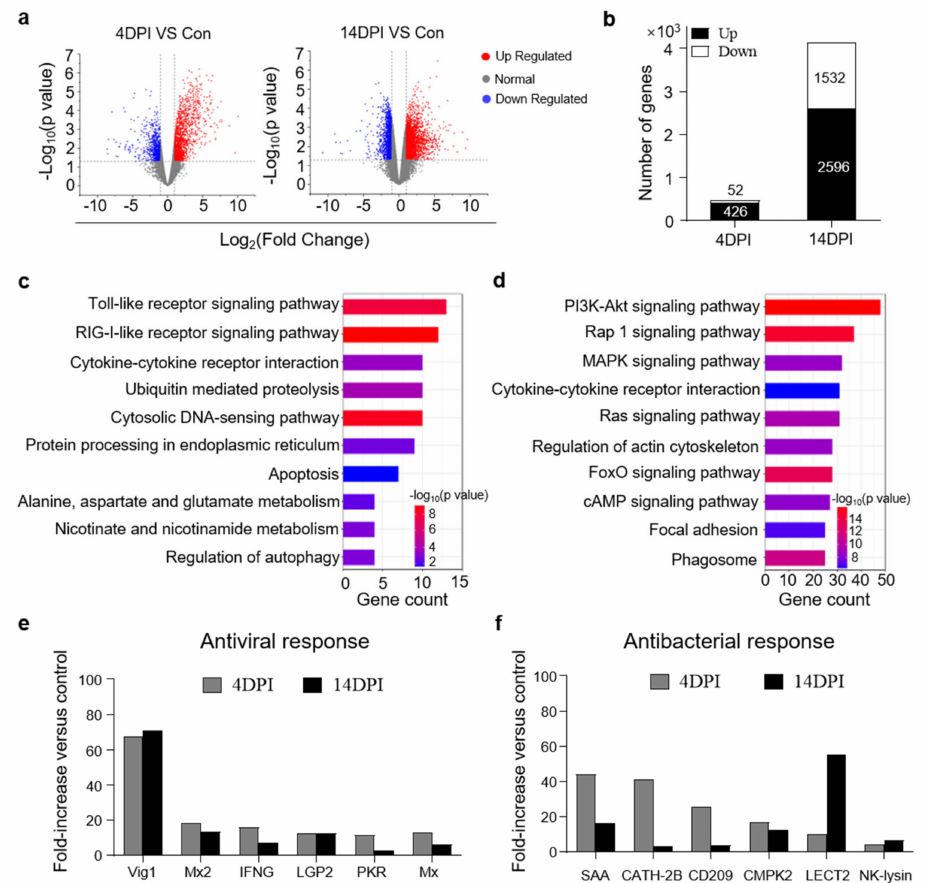
Figure 3. Transcriptome analyses of trout gut upon IHNV infection. ( a ) Volcano plot showing the overlap of genes upregulated or downregulated in the gut of rainbow trout at days 4 (left) and 14 (right) after infection with IHNV − infected versus control fish. Red spots are expression of fold change > 2 and FDR < 0.05; blue spots are expression of fold change < 2 and FDR < 0.05; grey spots mean no difference in expression. ( b ) The counts of upregulated or downregulated genes in the gut of rainbow trout at 4 or 14 DPI versus control fish. ( c , d ) KEGG pathways were significantly altered in gut of rainbow trout at 4 and 14 DPI versus control fish revealed by RNA − seq studies. ( e , f ) Representative antiviral ( e ) and antibacterial ( f ) response genes modulated by IHNV infection at 4 and 14 DPI. Fold change differences between control and IHNV − infected groups were calculated using cutoff of